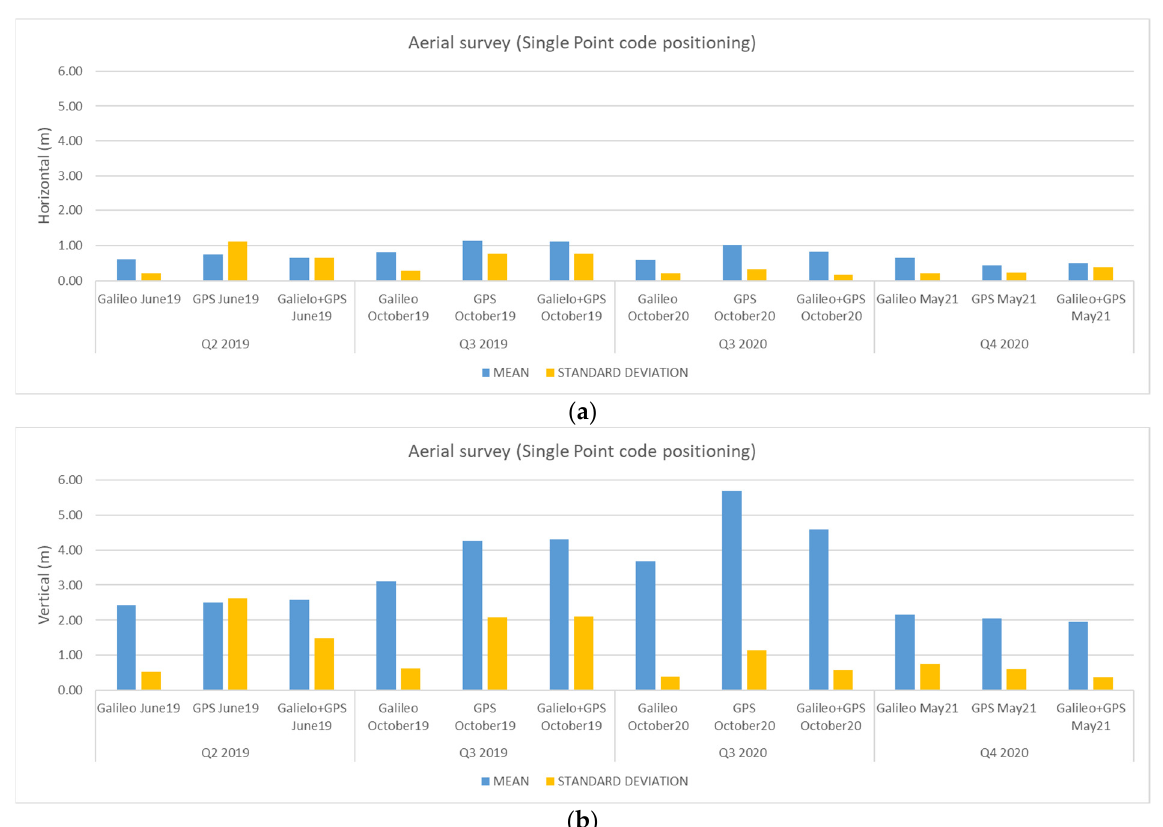
Figure 12. Horizontal ( a ) and vertical ( b ) mean values and standard deviations (in meters) for the SPP code solutions in the different campaigns using CSRS-PPP as reference.